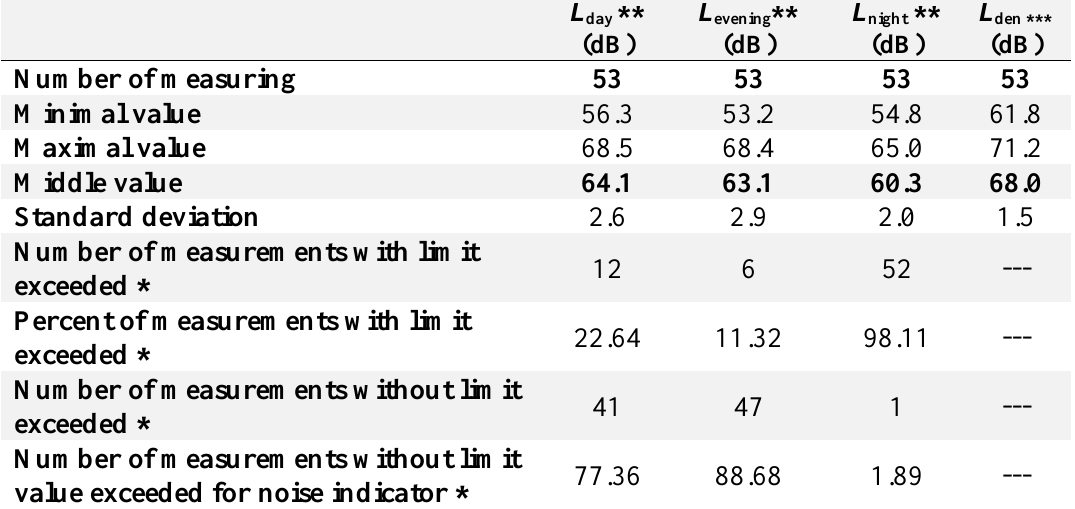
Table 2. Statistical data processing and consistency of values of basic noise indicators ( L L and L ) in the environment of the City of Novi Sad with boundary values evening night on three measuring points in the "zone of the city center and city roads" during the period 2012 −